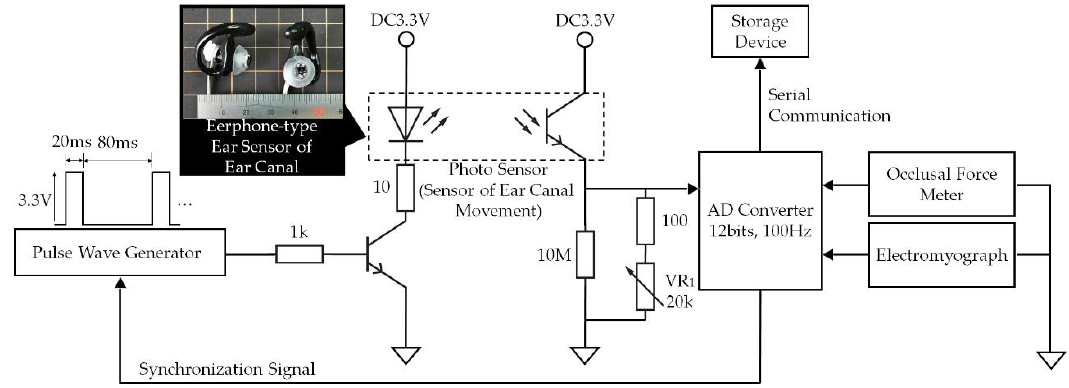
Figure 1. Experimental system. In this system, analog signals ranging from 0 V to 3.3 V measured using occlusal force meter, electromyography and the ear sensor to measure the movement of the ear canal are converted into digital signals by the analog-to-digital converter at a sampling frequency of 100 Hz with 12 bit resolution; the digital signals are then recorded together with timestamps in a storage device.